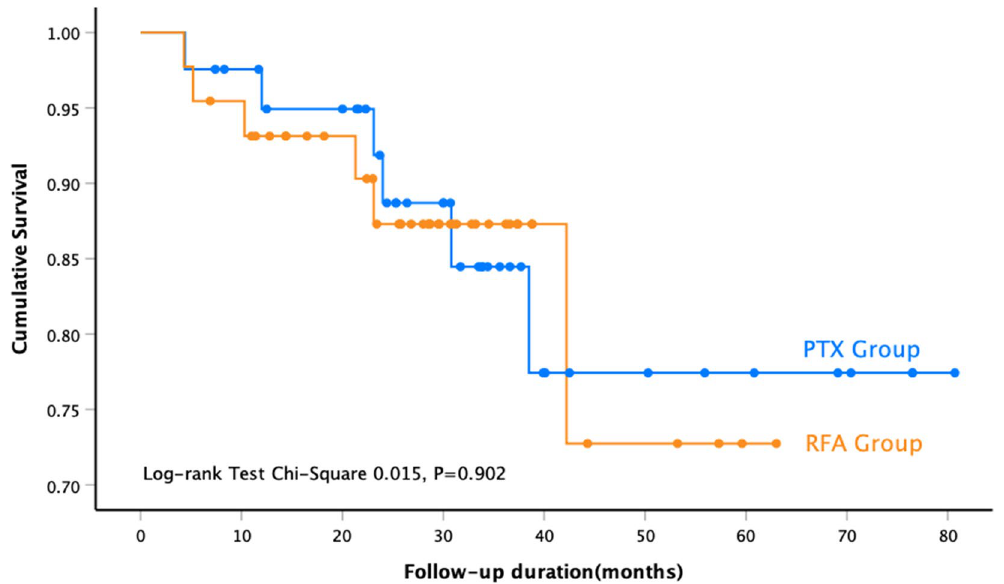
Figure 2. Survival analysis of all-cause mortality after parathyroidectomy or ultrasound-guided radiofrequency ablation.